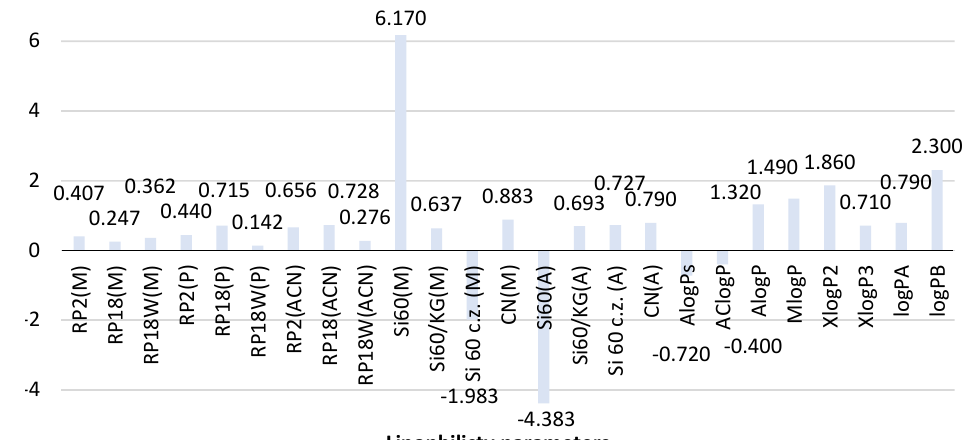
Figure 3. Comparison of the lipophilicity parameters of phenformin obtained using different methods. ACN-acetonitrile; A-acetone, M-methanol, P-propan-1-ol-organic modifier in the mobile phase, Si60-silica gel plates, Si60c.z.-silica gel plates with concentrating zone, Si60/KG-chromatographic plates precoated with the mixture of silica gel60 and Kieselguhr F 254 , CN-silica gel modified with cyano